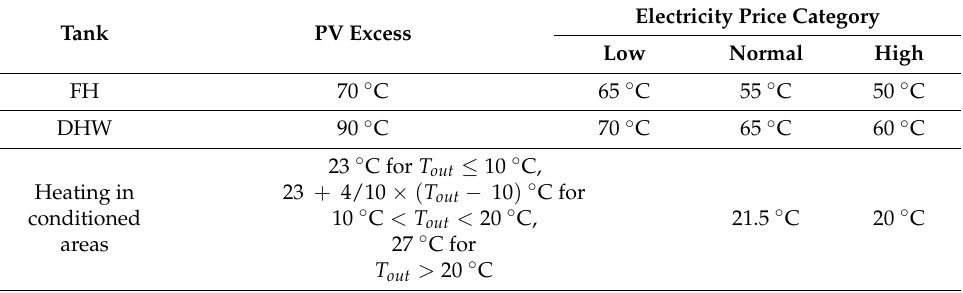
Table 3. The set-point temperatures of the floor heating (FH) tank, the domestic hot water (DHW) tank, and of heating in the conditioned areas, the latter according to the guidelines for the S2 category in the Classification of Built Environment [23] .